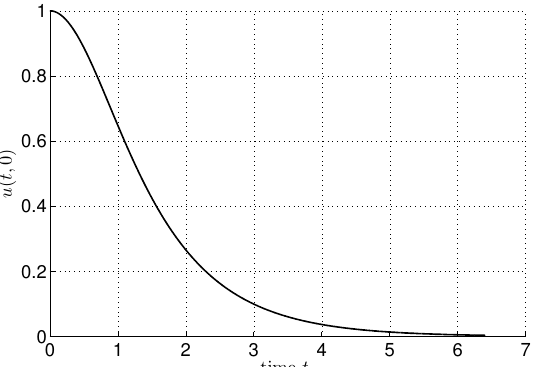
Figure 1. The soliton pulse defined in (55).